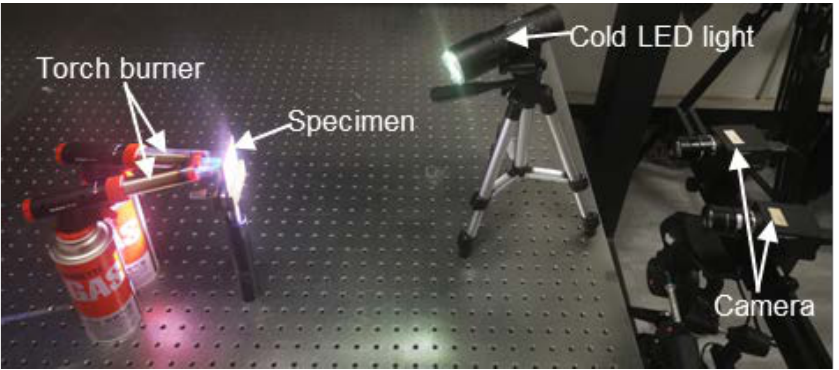
Figure 9. Experimental setup of the high-temperature deformation